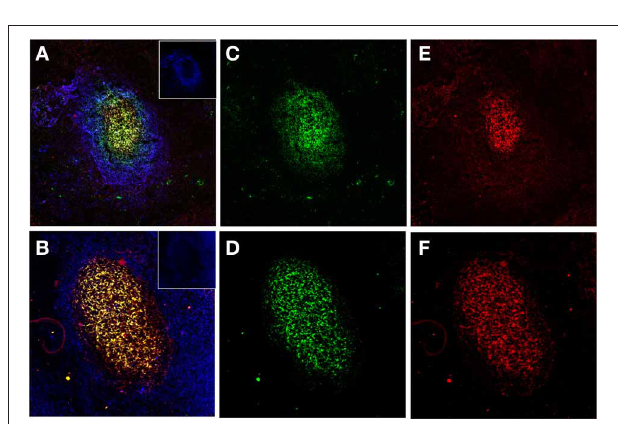
FIGURE 2 | Human FDCs in tonsillar sections trapping IgG/C3- opsonized Ags in ICs. (A and B) Two B-cell follicles surrounded by resting IgD+ mantle B-cells (blue, insets in the right upper corner). The overlay of FDCs in the follicles (labeled green with CNA.42mAb) and the FDC-trapped ICs (labeled red with anti-human IgG in the upper panel and anti-C3 in the lower panel) is orange-yellow. (C and D) FDCs labeled green with the FDC-specific mAb CNA.42. (E) Human IgG in the FDC-trapped ICs labeled red with anti-human IgG. (F) Human C3 in FDC-trapped ICs labeled red with anti-human